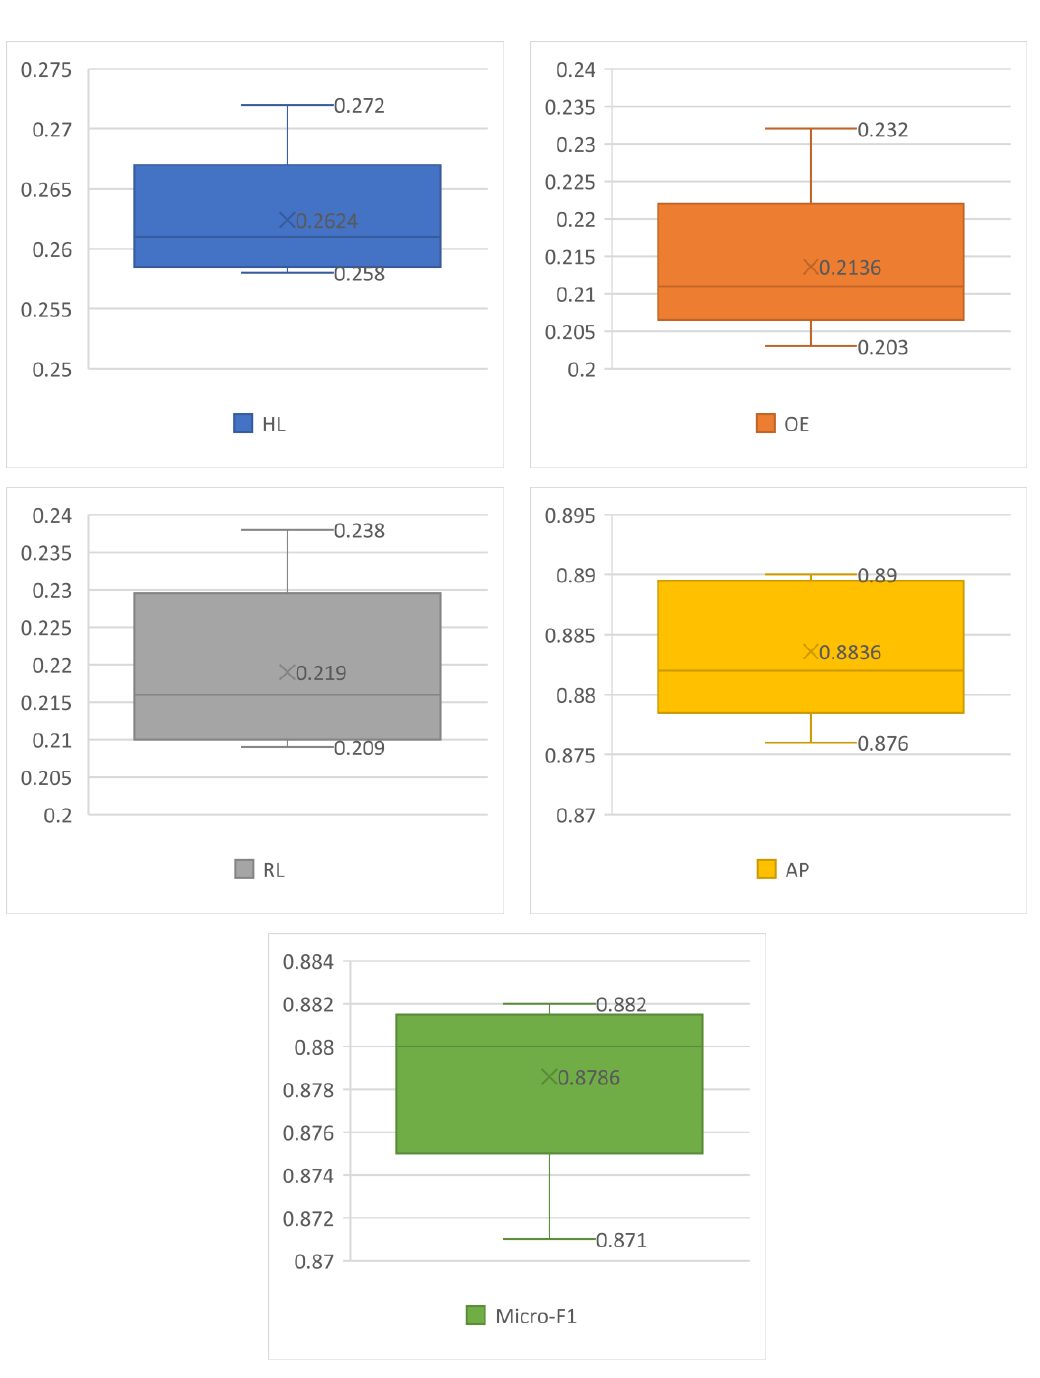
Figure 4. Model experimental results.